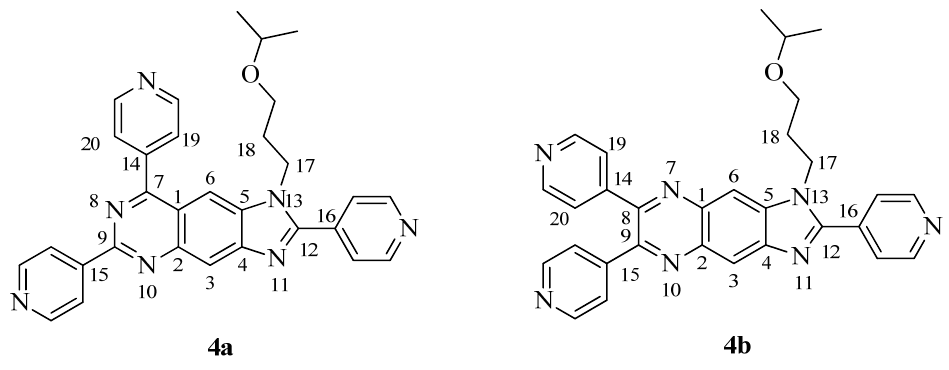
Figure 1. Two possible chemical structures of compound 4